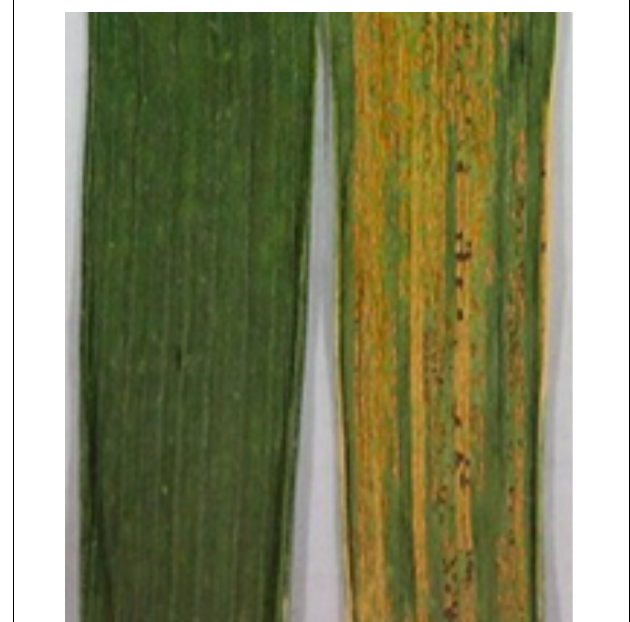
FIGURE 1 | Adult plant leaves of Baidatou (left) and Mingxian 169 (right) inoculated with Chinese Pst race CYR33 at Yangling field in 2014–2015 crop season.